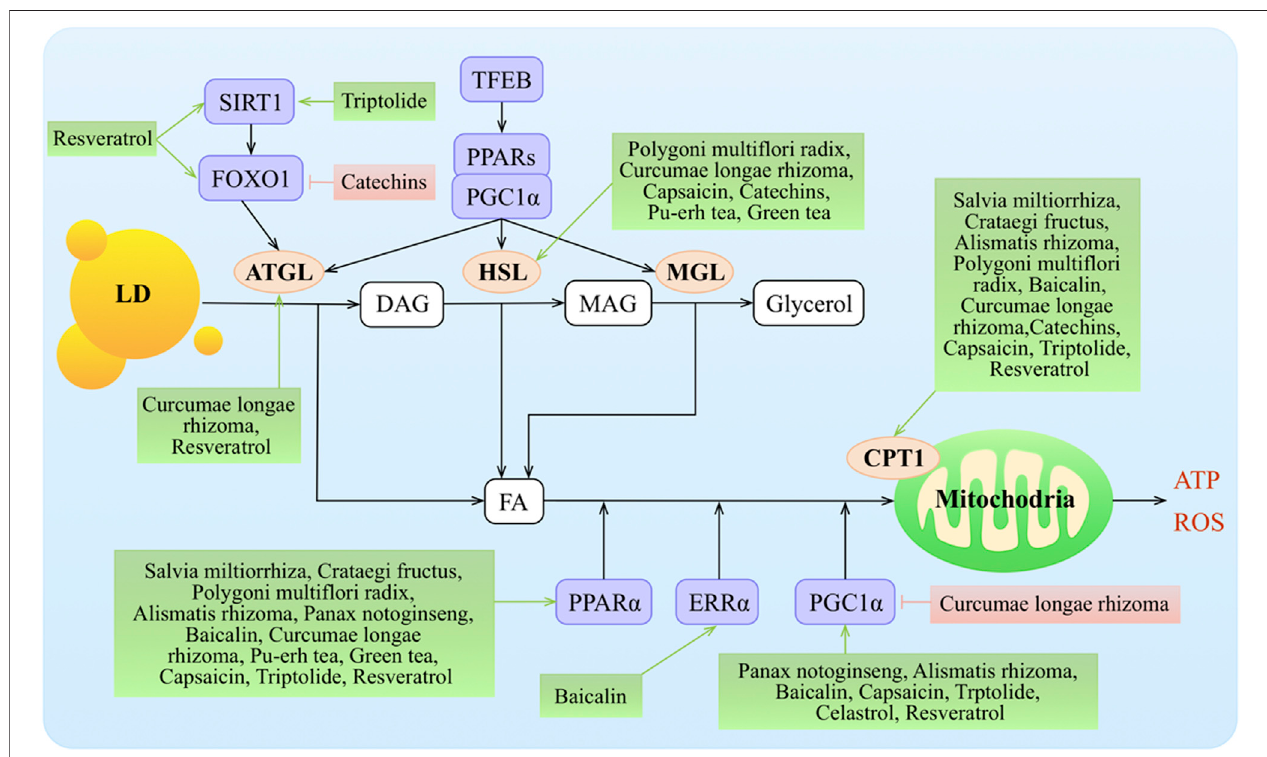
FIGURE4| MolecularmechanismsofTCMsinlipiddecomposition.TCMsstimulatelipolysisfromfatstoresintheliver,whiteadiposetissue,anddietaryfatsources (high-fat diets) to generate FAs that enter the hepatic cells via protein transporters. TG stored as lipid droplets can be hydrolyzed back to FAs via classic lipases (ATGL, HSL, and MGL) and lipophagy (by regulating TFEB, SIRT1, and FOXO1), undergo mitochondrial β -oxidation by the activity of various co-activators or nuclear receptors (such as PPAR α , ERR α , and PGC1 α ),and target the transcription of gene Cpt1. Malonyl-CoA, an intermediate in DNL, inhibits CPT1 action and downregulates FA oxidation. ↑ / ⊥ depicts the positive or negative effect of TCMs in the cellular process,